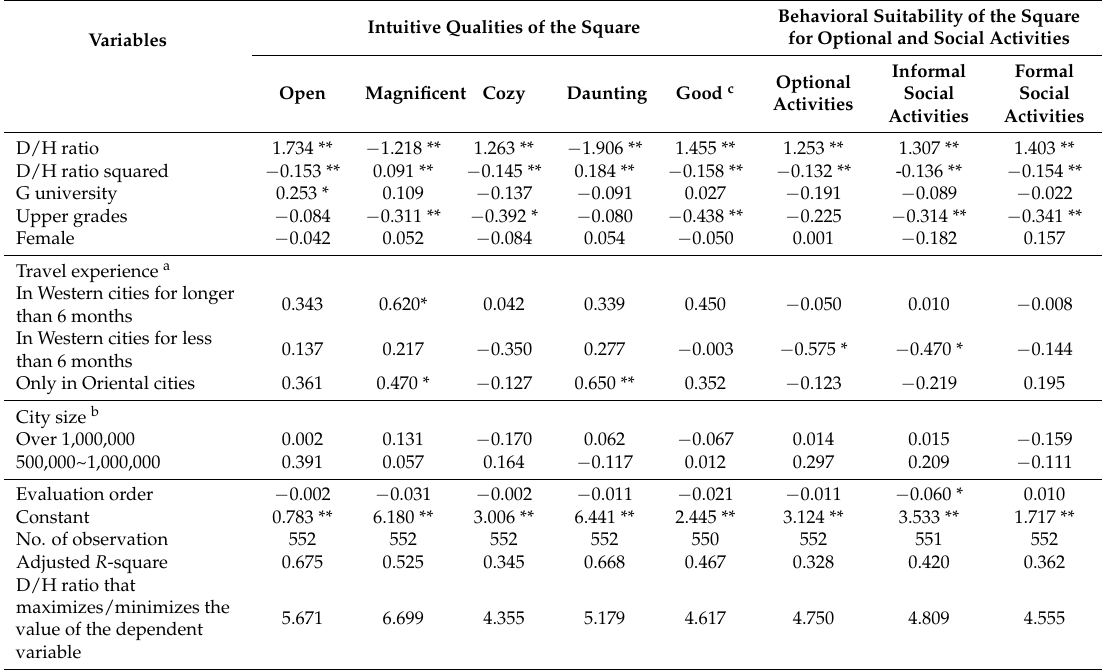
Table 5. Quadratic regression estimates on the intuitive qualities of the public squares and their behavioral suitability for optional and social activities. Behavioral Suitability of the Square Intuitive Qualities of the Square for Optional and Social Variables